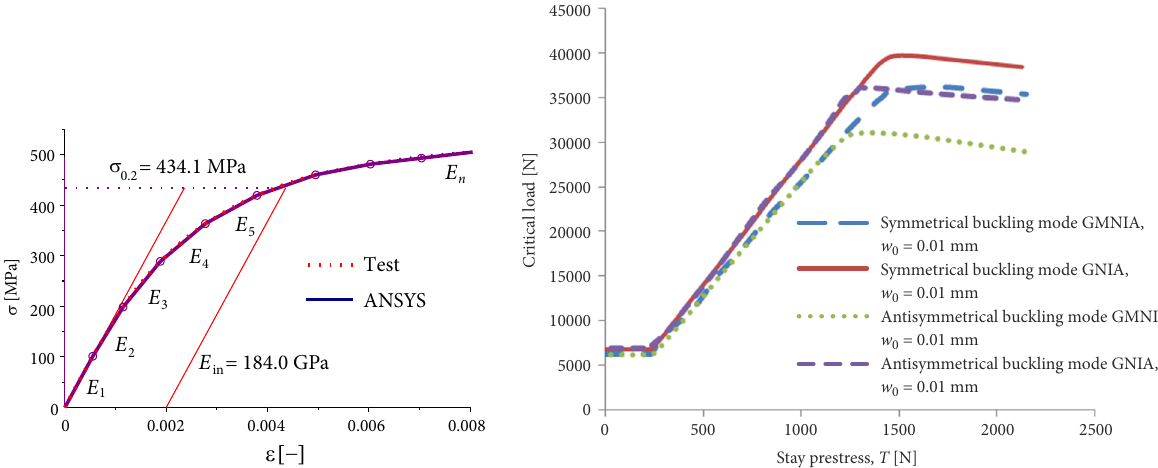
= 0.01 mm; w = 5 mm) 0x 0z and N (right) cr,sym cr,anti